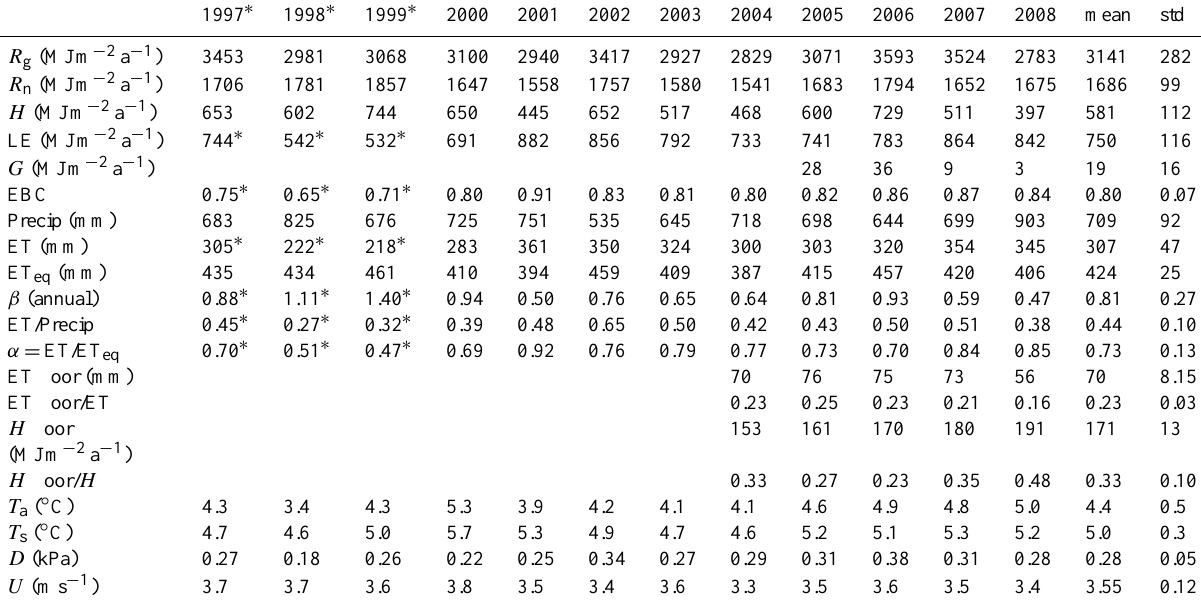
Table 1. Annual energy fluxes and mean climate characteristics over 1997–2008 period: R g and R n are global and net radiation, H , LE and G sensible, latent and soil heat fluxes. EBC is the energy balance closure ratio, Precip and ET annual precipitation and evapotranspiration, ET eq the equilibrium evaporation (Eq. 6), β Bowen ratio ( H /LE), T a and T s air and soil temperatures, D vapor pressure deficit and U mean wind speed. Values marked with ∗ should be interpreted with care because the LE values in 1997–1999 are likely to be underestimates.